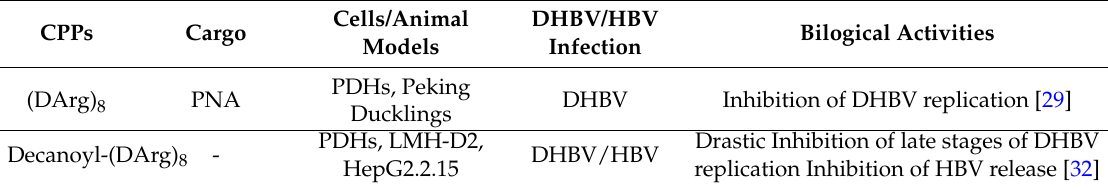
Table 1. Different CPPs and their therapeutic potential against hepatitis B.